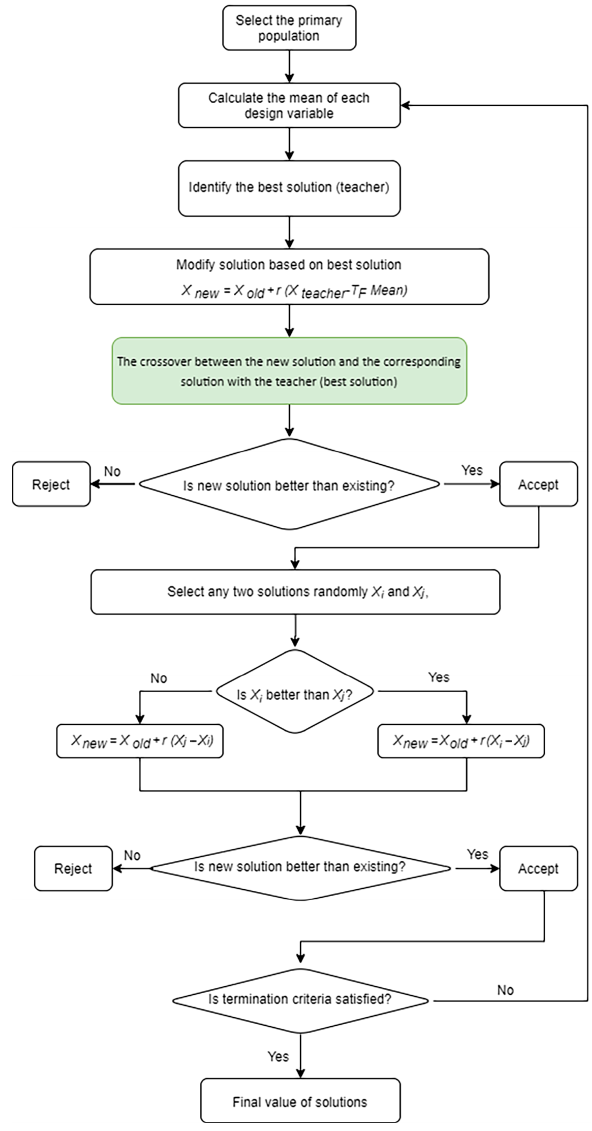
Figure 1. The flowchart for